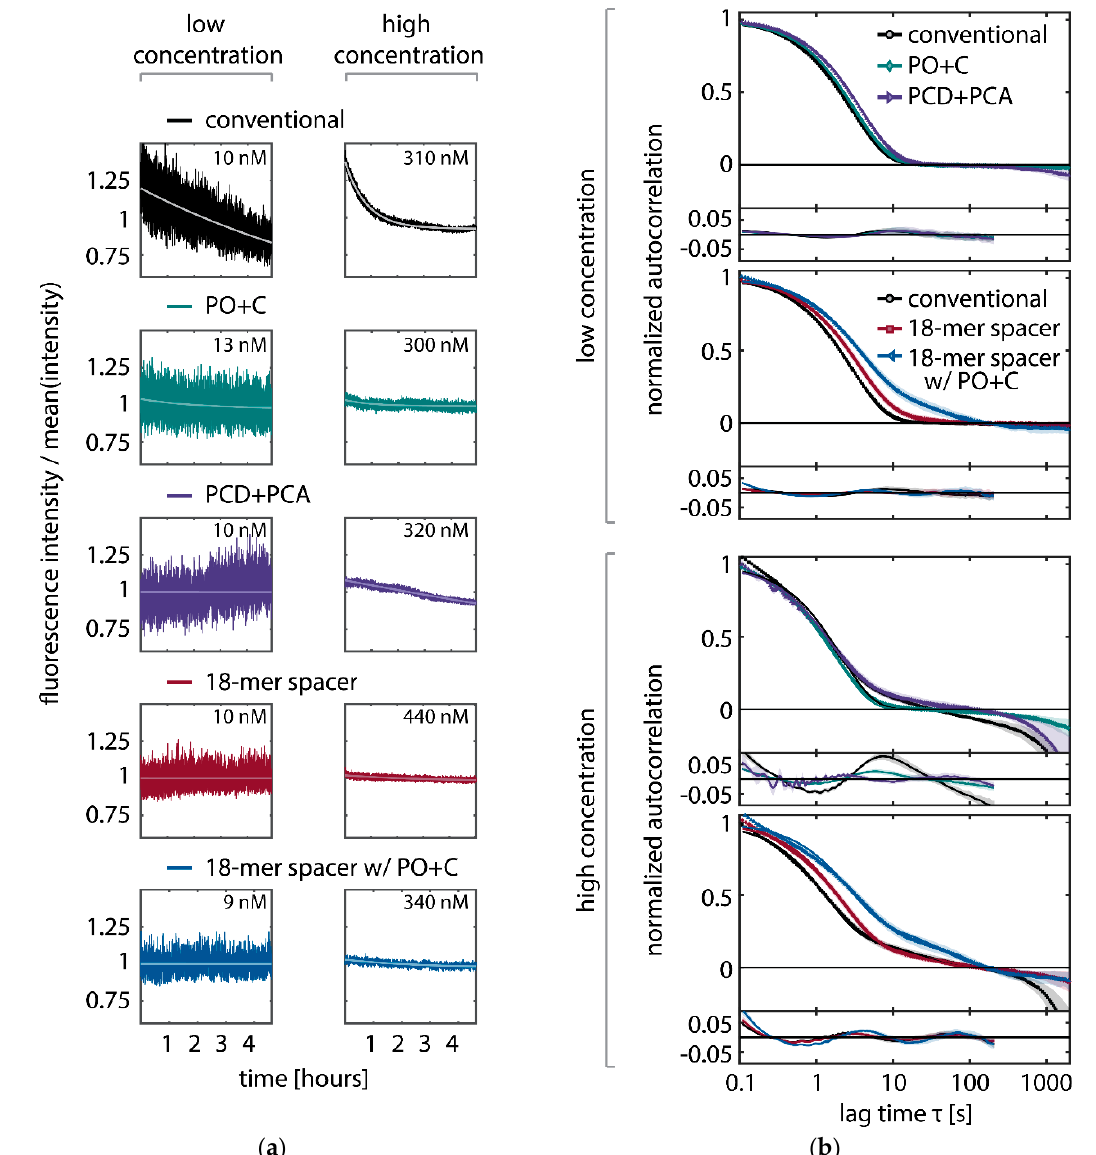
Figure A7. Influence of the depletion of binding sites on the autocorrelation function: (a) Decays of the integrated fluorescence intensity within a representative region of interest (dark shade) and fit of the mono-exponential detrending function (equation 1, light shade). For all five conditions (conventional, addition of oxygen scavenging system (PO+C and PCD+PCA), 18-mer spacer and 18-mer spacer with PO+C) an example at low and high concentration is shown. The concentrations of individual samples were measured by confocal FCS. (b) Representative normalized autocorrelation functions and residuals with conditions as in (a) (solid lines). Shaded areas represent the standard deviation from 64 regions of interest.